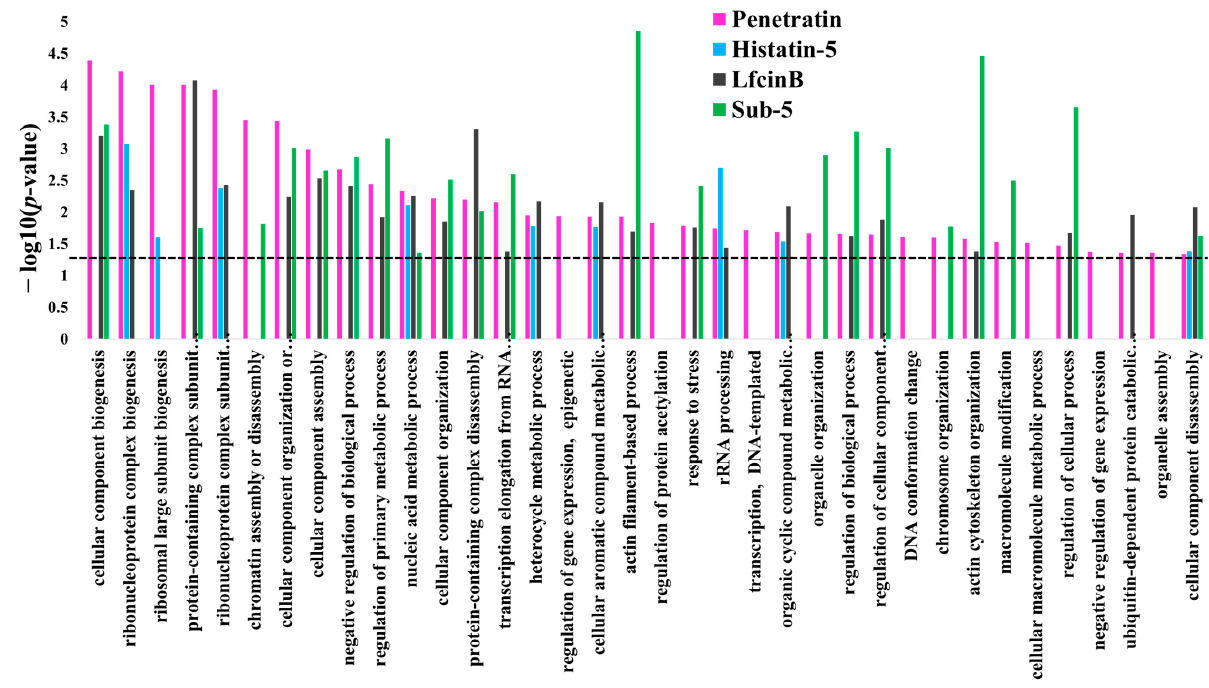
Figure 10. Comparison of the non-redundant enrichment terms in biological process for the protein targets of penetratin with the non-redundant enrichment terms for the protein targets of Histatin-5, Lfcin B, and Sub-5. Enrichment in biological process was individually obtained from DAVID database for the protein targets of penetratin, Histatin-5, LfcinB, and Sub-5. These enrichment results were analyzed by REVIGO to identify non-redundant enrichment terms. The non-redundant enriched terms in the biological process for the protein targets of penetratin, Histatin-5, LfcinB, and Sub-5 were compared. Dotted line represent p -value = 0.05.